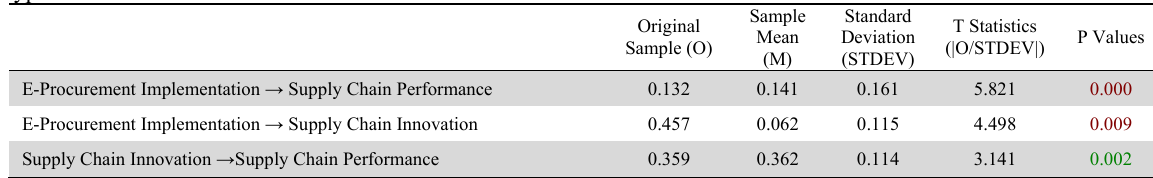
Table 3 is presented to clarify the picture of the hypothesis test above. Table 3 Hypothesis Test